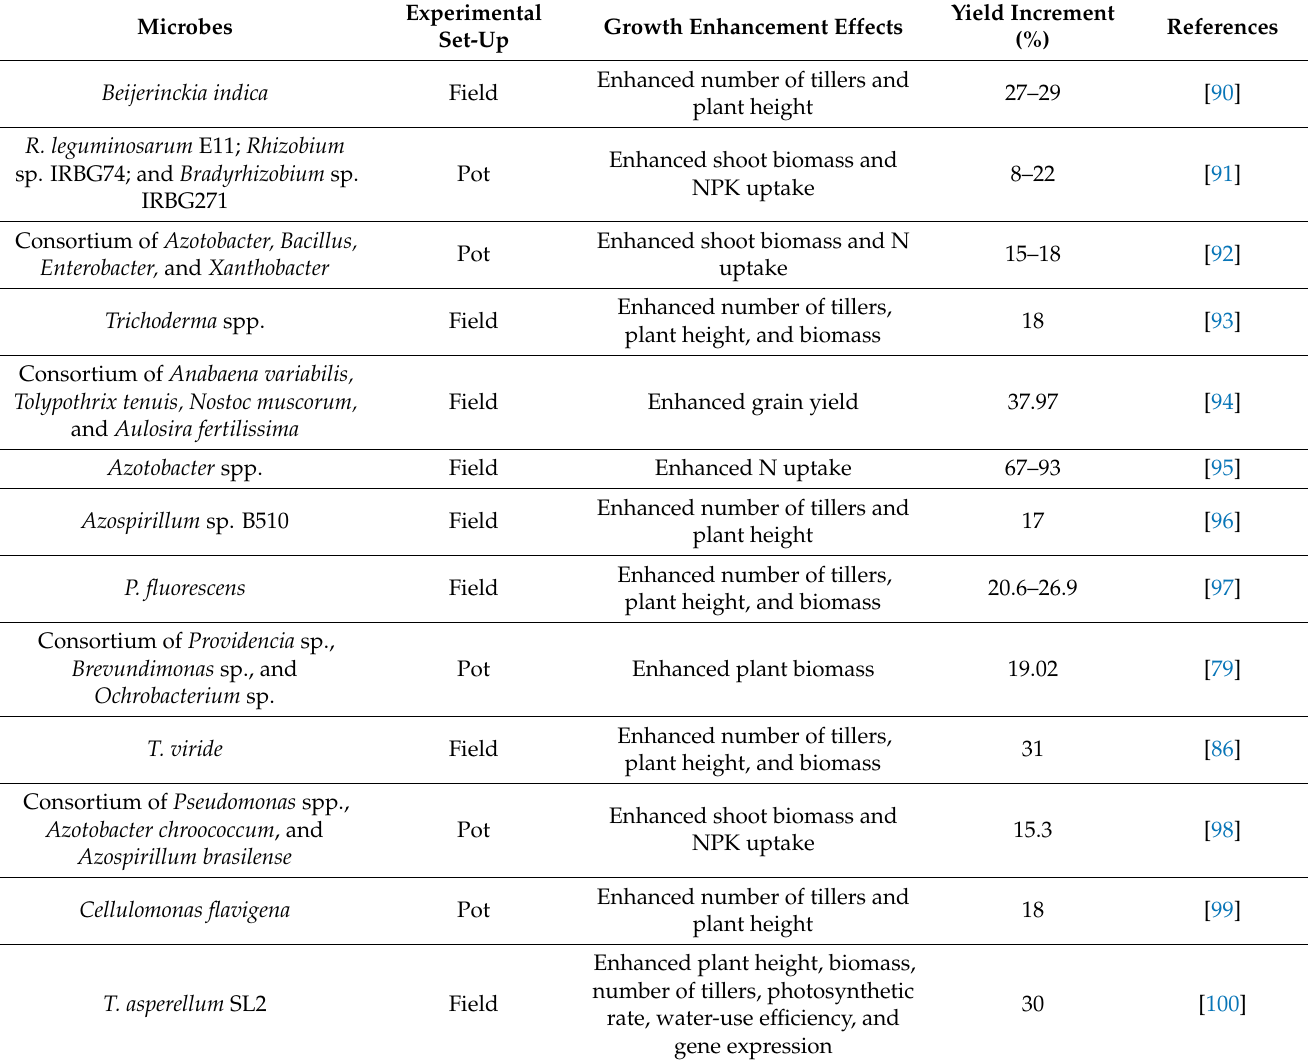
Table 1. Contributions of microorganisms for the enhancement of rice